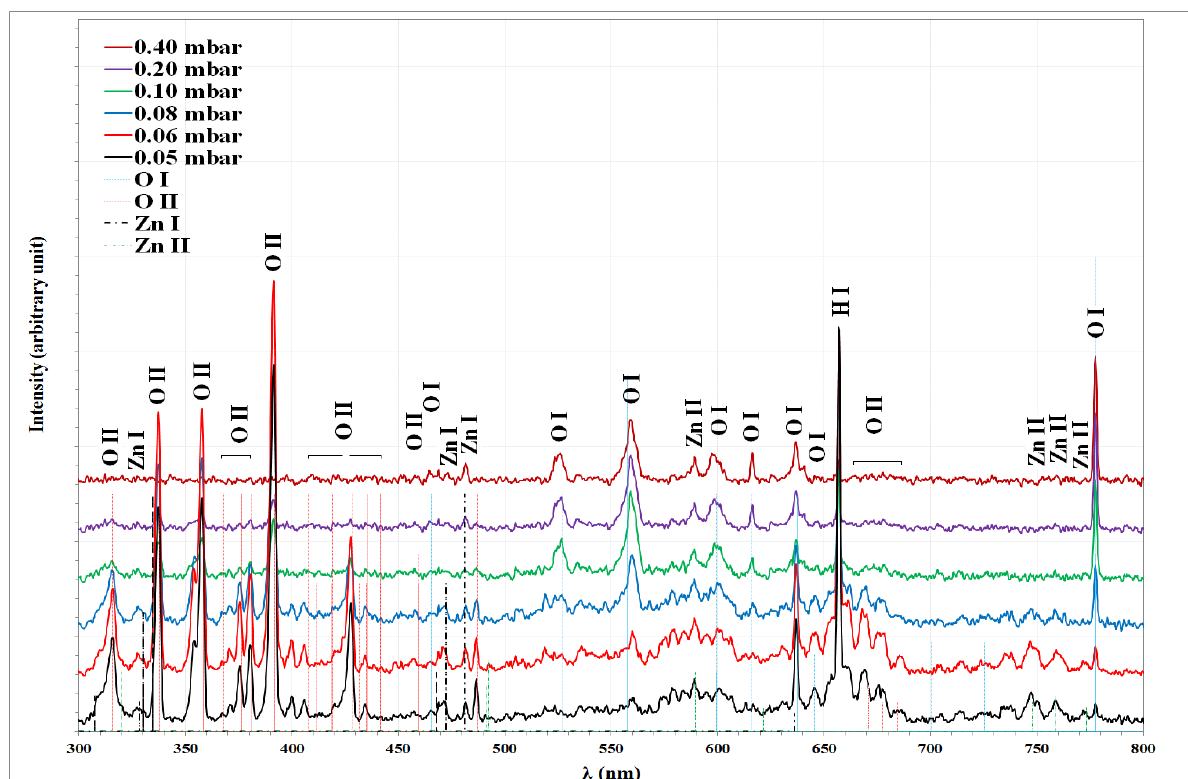
Fig. 5: Emission spectra for RF plasma in oxygen with different working pressure using Zn